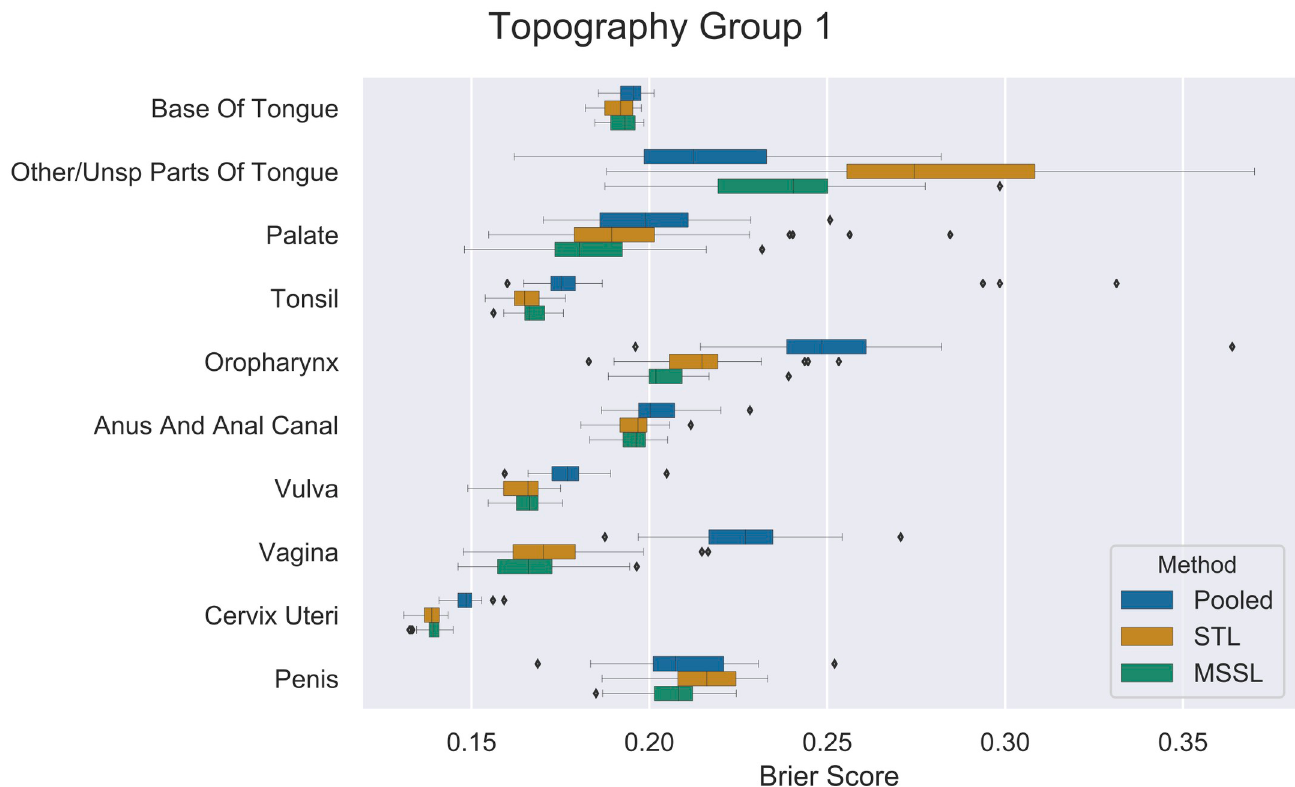
Fig 2. Brier scores (x-axis) for pooled, STL, and MSSL classifiers for Topography group 1 data split. Boxplots show results from 30 independent runs.